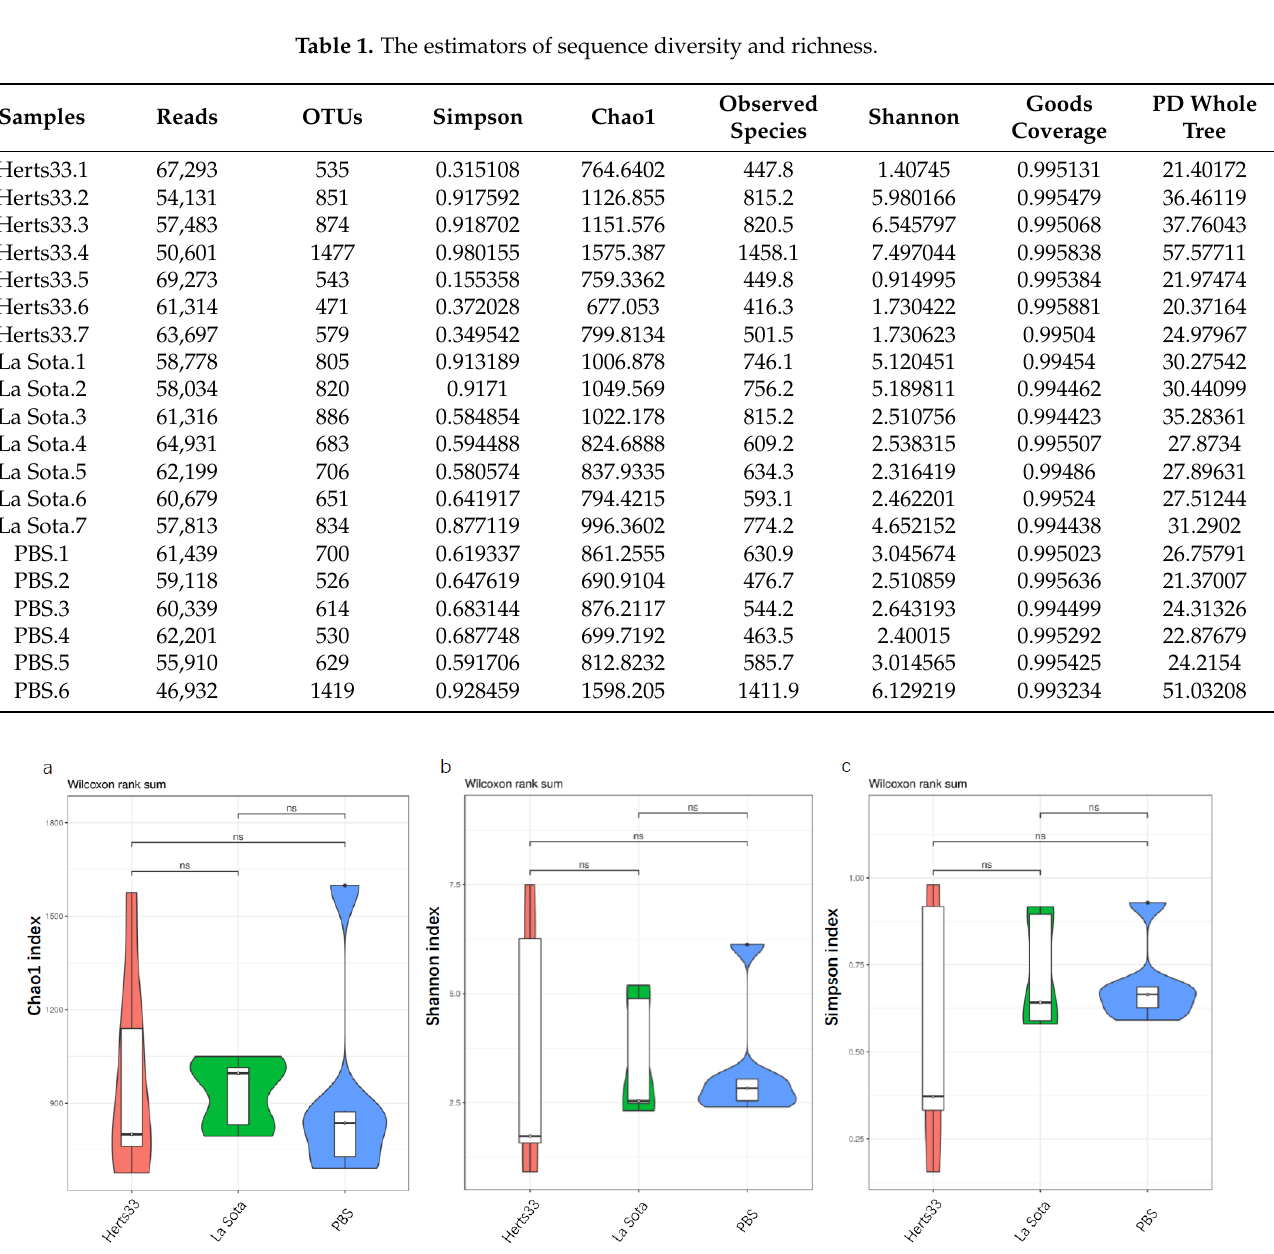
Figure 2. The microbial diversity index analysis. ( a ) Chao index. ( b ) Shannon index. ( c ) Simpson index. ns: no significant difference ( p > 0.05).